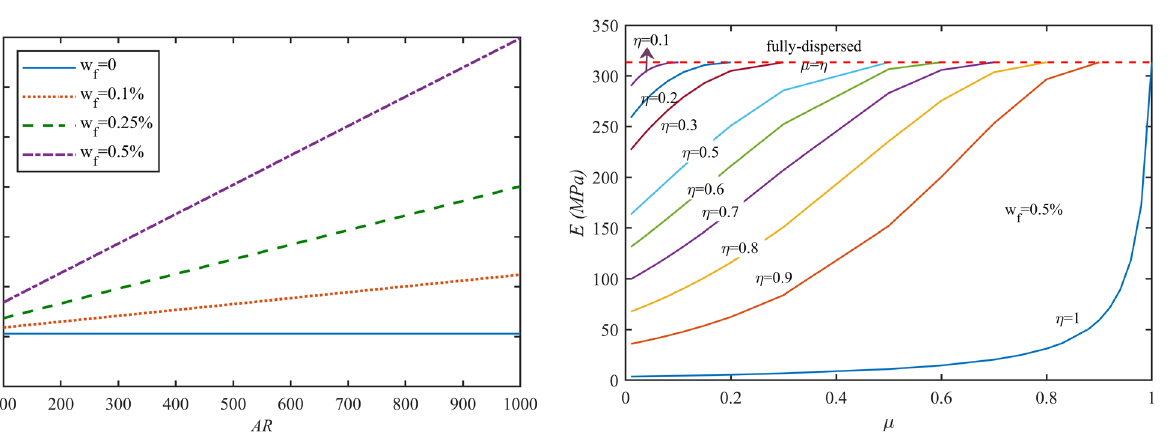
Figure 9: Young ’ s modulus of PDMS/MWCNT nanocomposite obtained from EMT ’ s approach versus MWCNT cluster sizes for dif - ferent concentrations of MWCNTs inside clusters when w f =